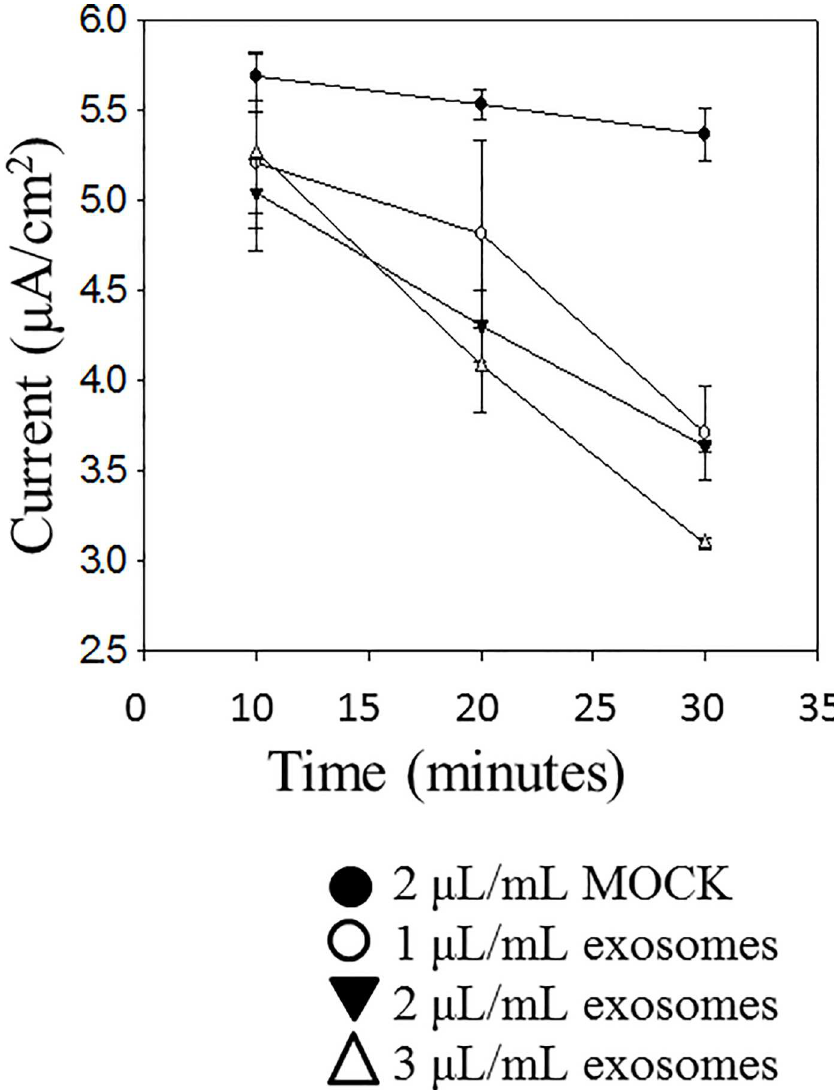
Fig 6. Effect of exogenous application of apical exosomes from LLC-PK1 cells on amiloride- sensitive transepithelial current measurement in mpkCCD cells. Cells were cultured for 10 days to allow the formation of tight junctionsand the measurement of resistancesand voltages across confluent monolayers. Exosomes isolated from conditioned media present on the apicalside of LLC-PK1 cells cultured on permeable transwellinserts were appliedto the apical side of mpkCCD cell monolayers. Applicationof these exosomes resulted in a time and dose dependent decrease in transepithelial current. Each point represents the mean ± s.e. from 3 separate inserts containingcells (N =